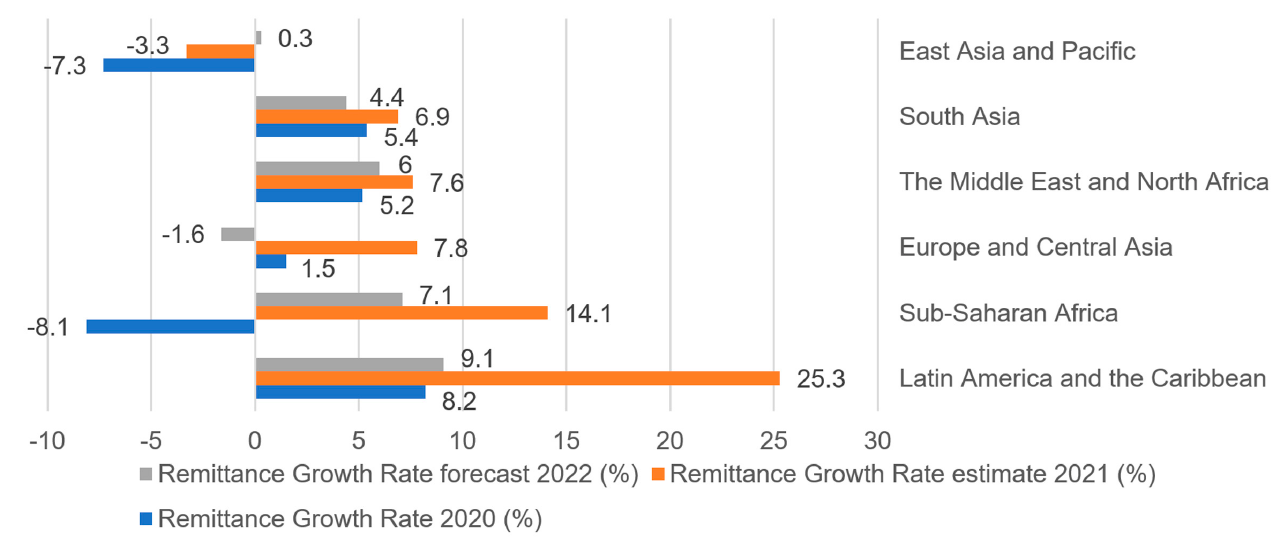
Figure 2. Remittance growth rate 2020–2022.